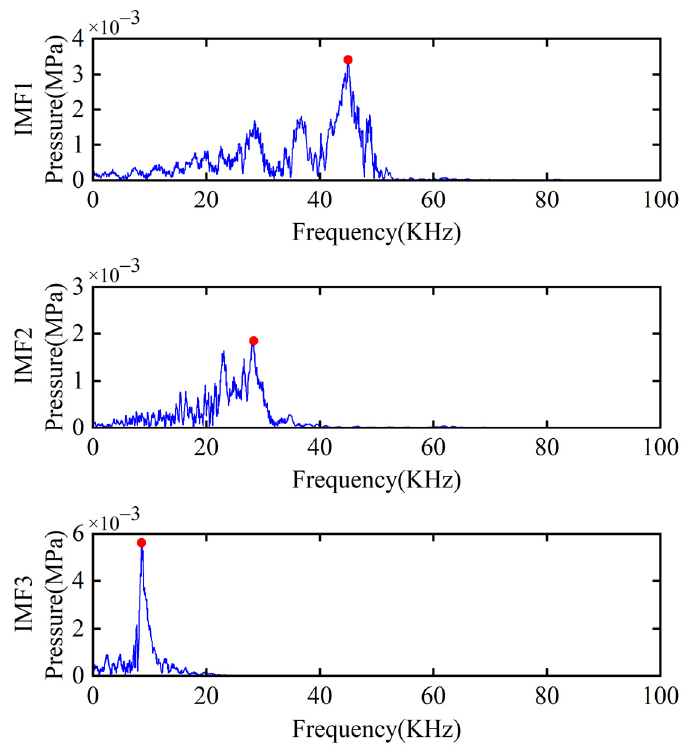
Figure 7. FFT spectrum amplitude of IMF1~3. Table 2. Center frequency and pressure amplitude of each IMF component of in-cylinder pressure signal.